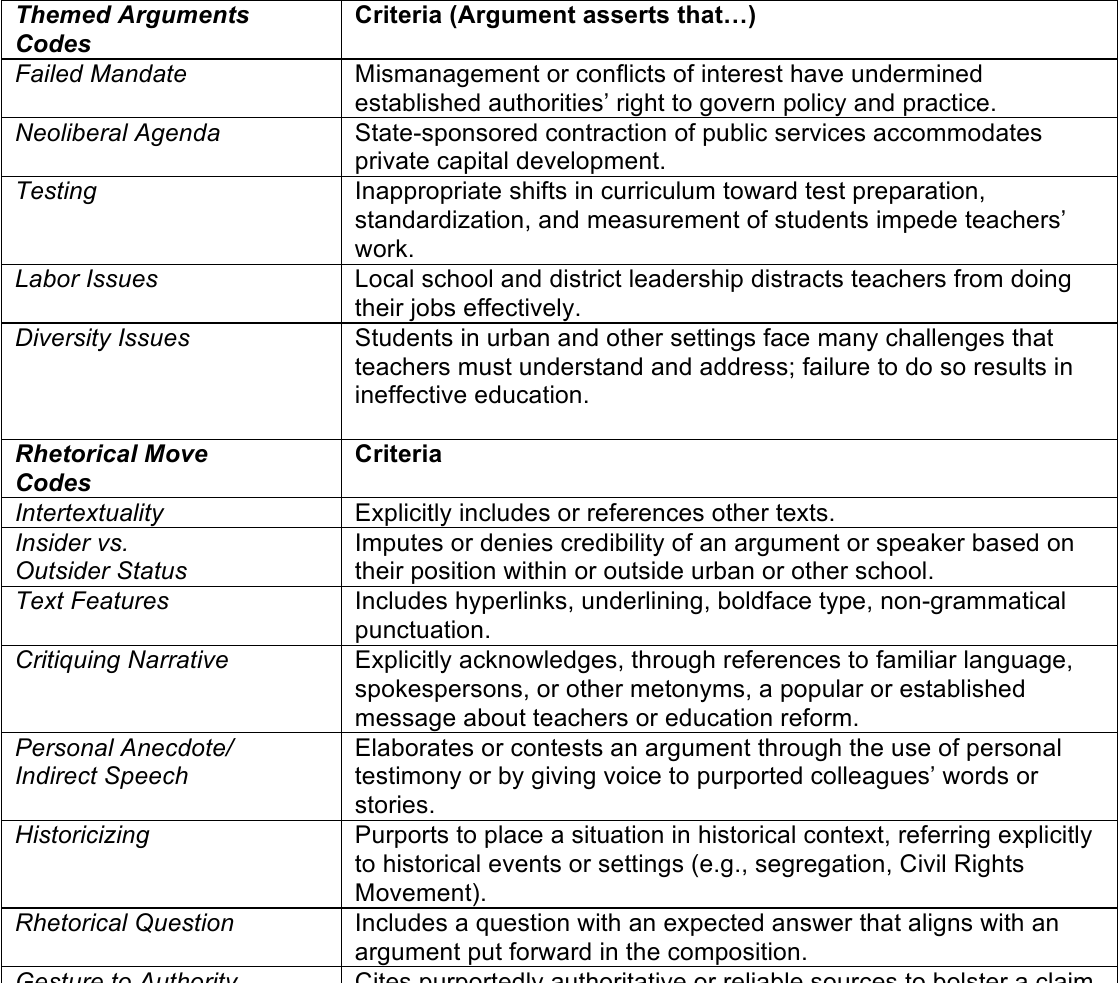
Figure 1. Coding categories and